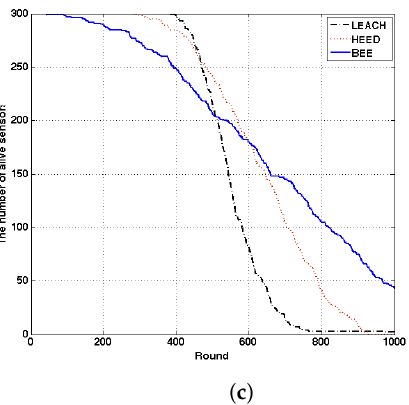
Figure 6. Comparison between HEED and BEE. ( a ) CH percentage; ( b ) The iterations required in each round; ( c ) Number of sensors still alive.